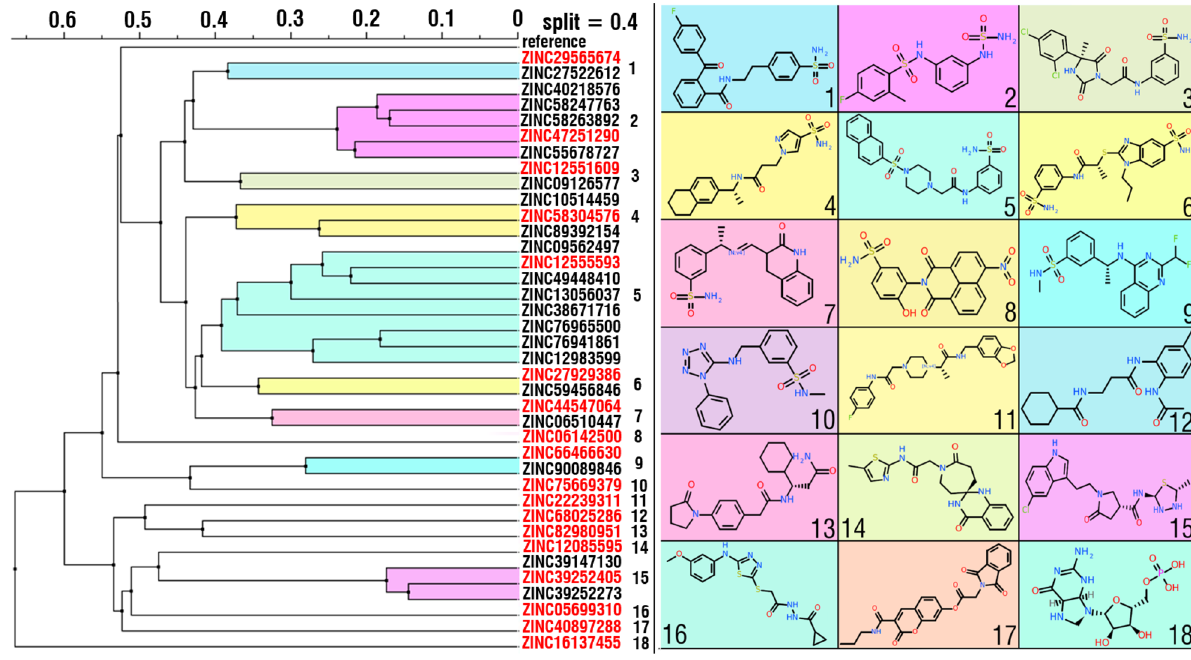
Figure 5. Results of the clusterization of the identified compounds as the result of MMGBSA re-scoring procedure. 2D structures of representative are presented for all 18 clusters. IDs of representative compounds of clusters with more than one compound are colored in red. Clusterization dendrogram and figures of chemical structures were obtained using ICM-PRO 51 (http:// www. molso ft. com/ icm_ pro. html). Schematic illustration was drawn using Adobe Illustrator 2018 (www. adobe. com/ produ cts/ illus trator).